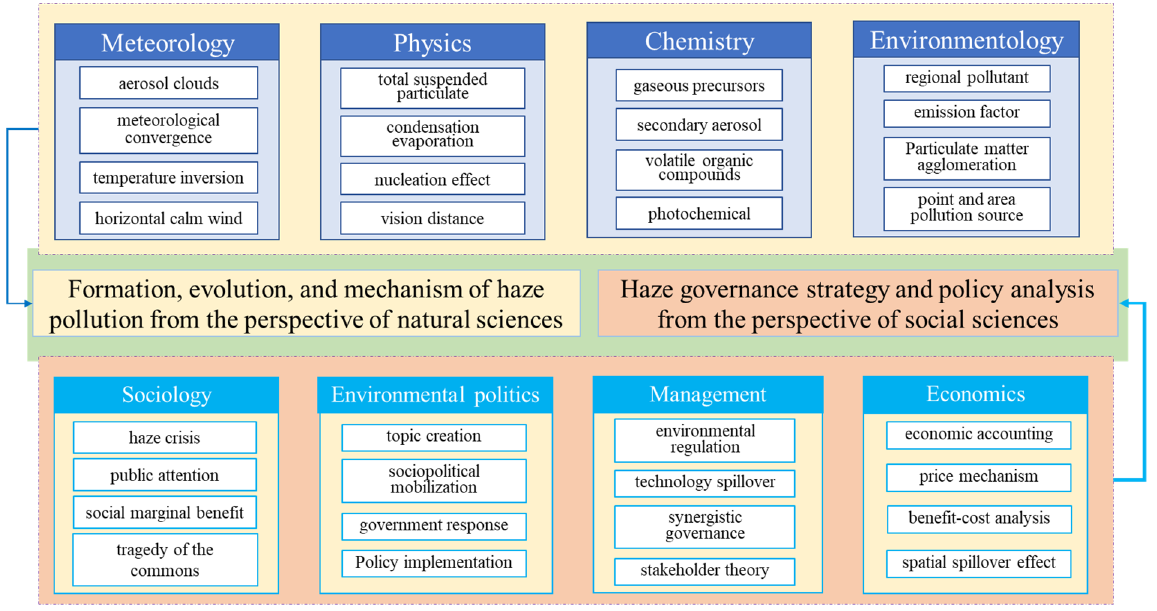
Figure 1. The structural framework and research focus of the existing literatures.